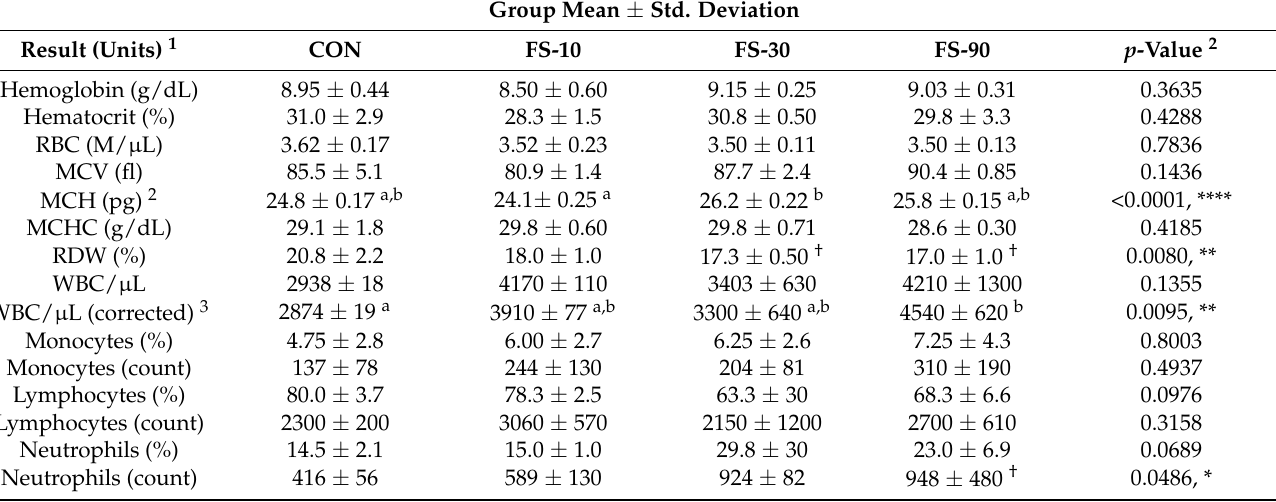
Table 1. Complete blood counts. Group Mean ± Std.